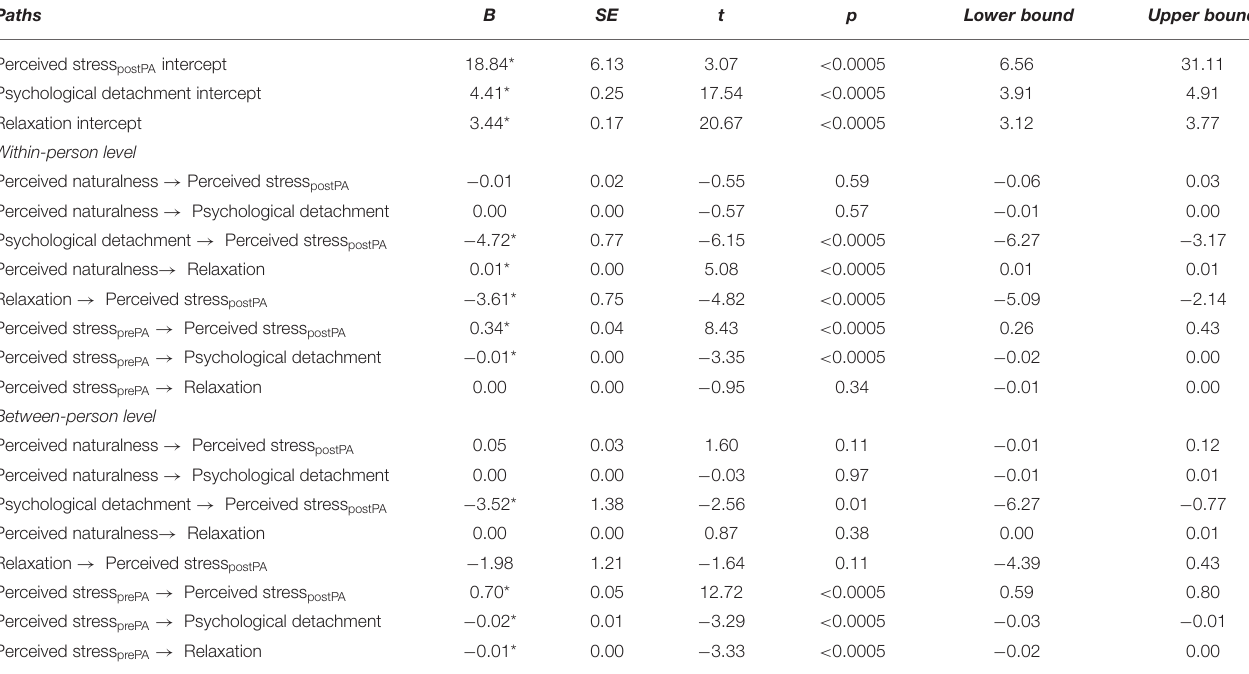
TABLE 2 | Results of the two-level mediation analysis: unstandardized regression coefficients (*, p < 0.05), standard errors (SE) with lower and upper bounds of the convidence interval.